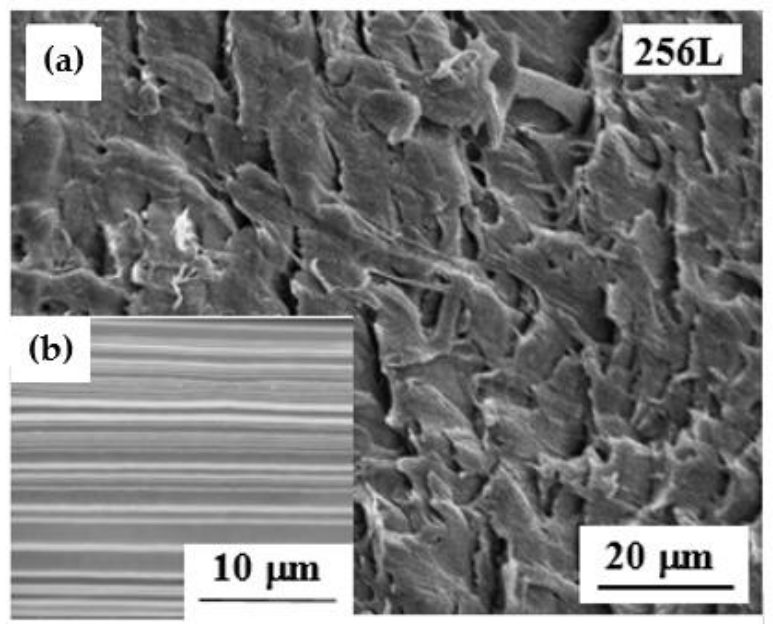
Figure 10. SEM micrographs of ( a ) the recycled R2-LDPE/PS-256L multilayer film and ( b ) the neat LDPE/PS-256L multilayer film with 50/50 composition.